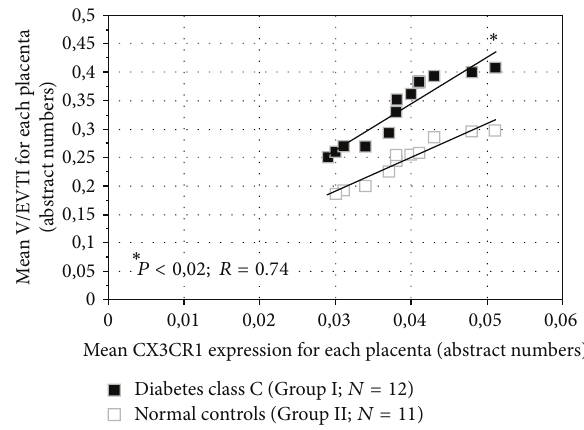
Figure 3: The mean values of V/EVTI versus the mean CX3CR1 expressions: diabetic and normal placentae,